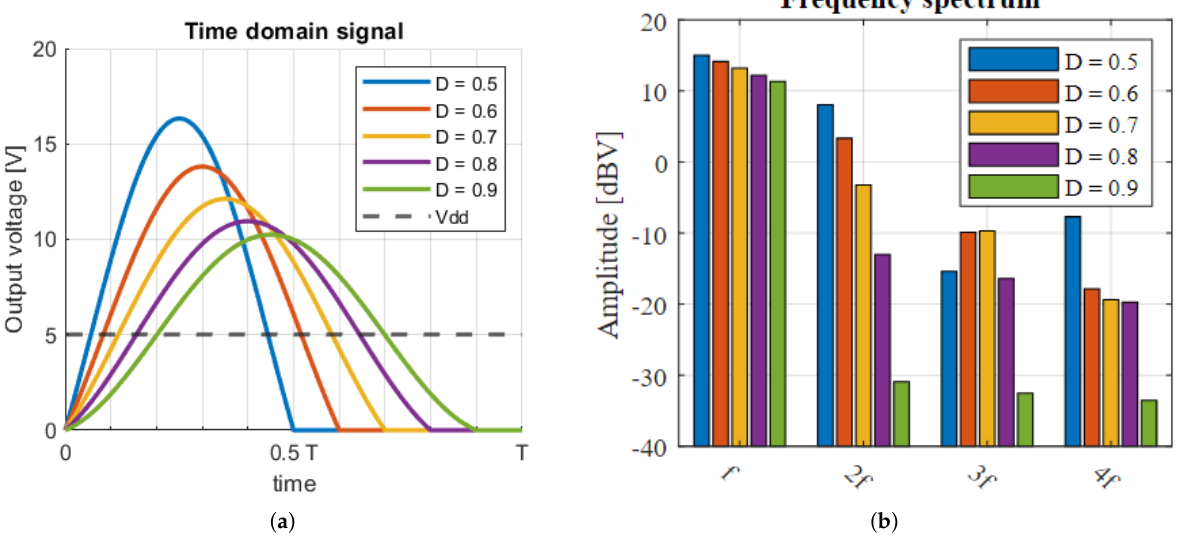
Figure 10. ( a ) Simulated time-domain waveforms of the output signal of the modified class-E amplifier. ( b ) Spectral use of the output